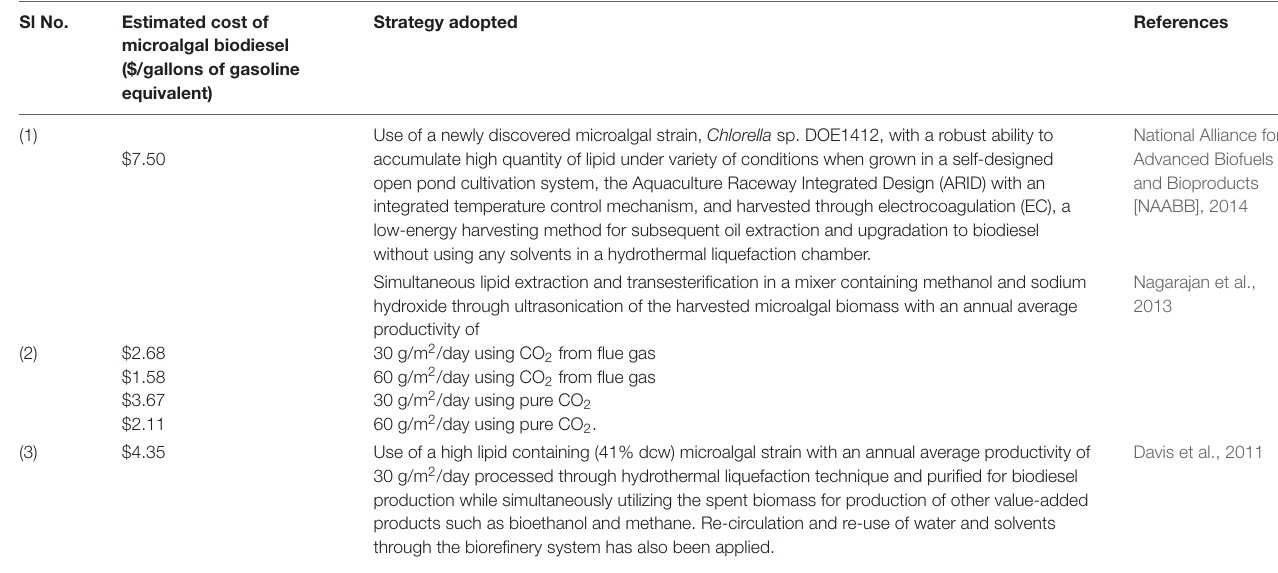
TABLE 2 | Strategies adopted for reducing the cost of microalgal biodiesel production. Sl